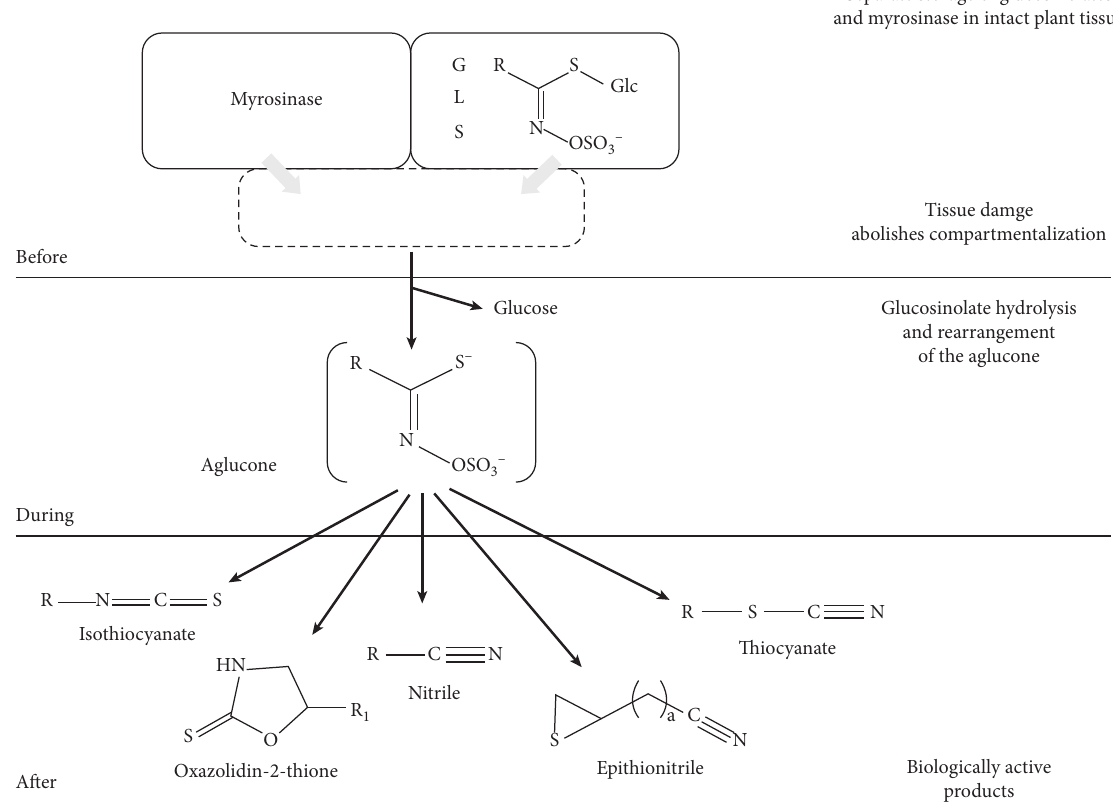
Figure 1: Functional and biological implications of the myrosinase-glucosinolate